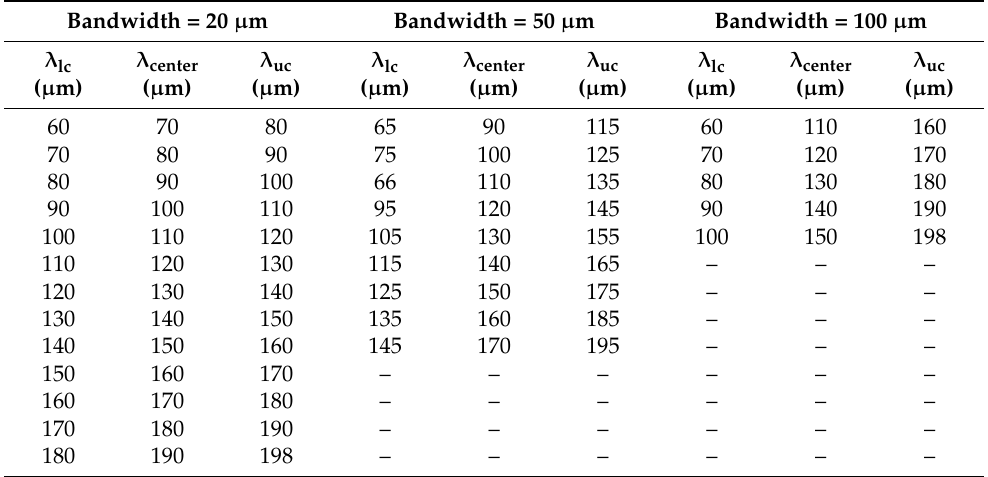
Table 1. Lower and upper cutoff and center wavelengths used in the bandpass filtering